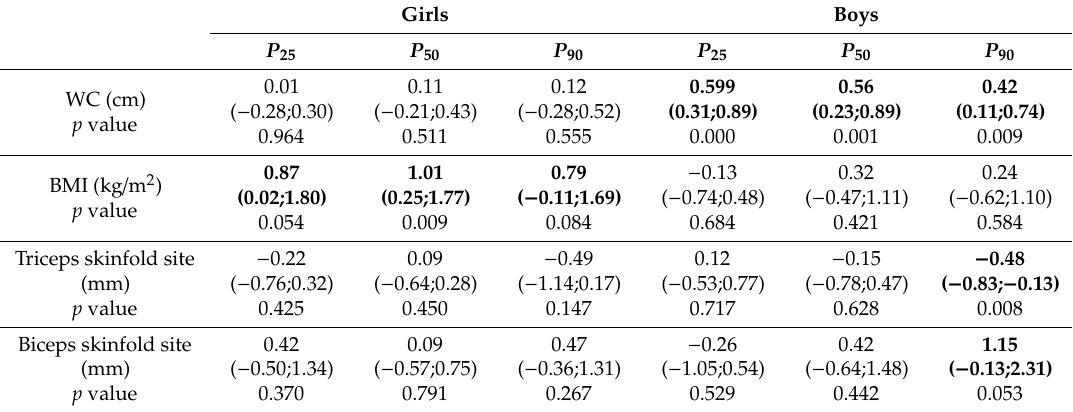
Table 3. Linear quantile regression for the association of systolic blood pressure with anthropometric indices of adiposity.